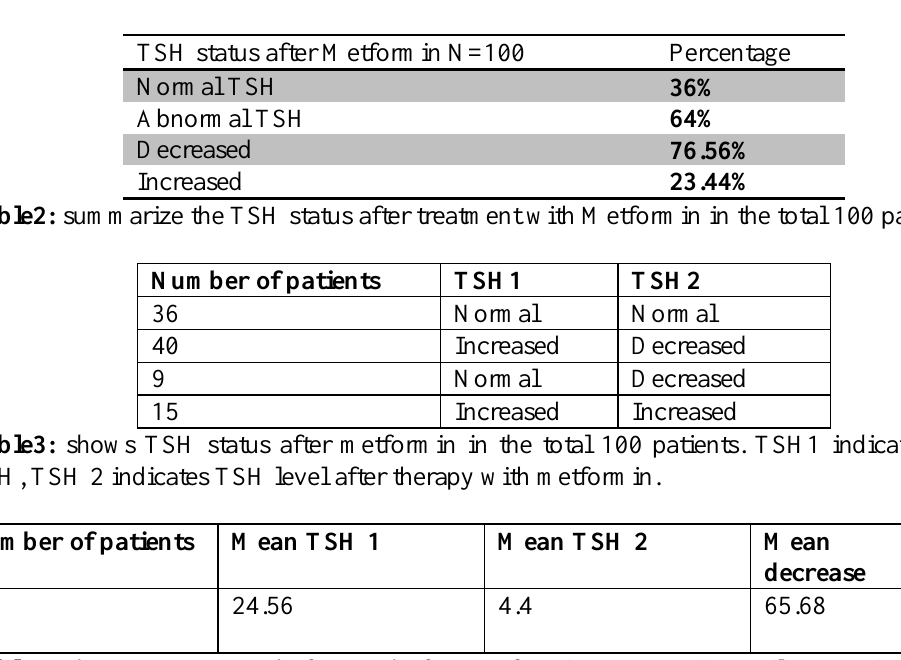
Figure 2: Different causes of primary hypothyroidism in the study patients N=100.